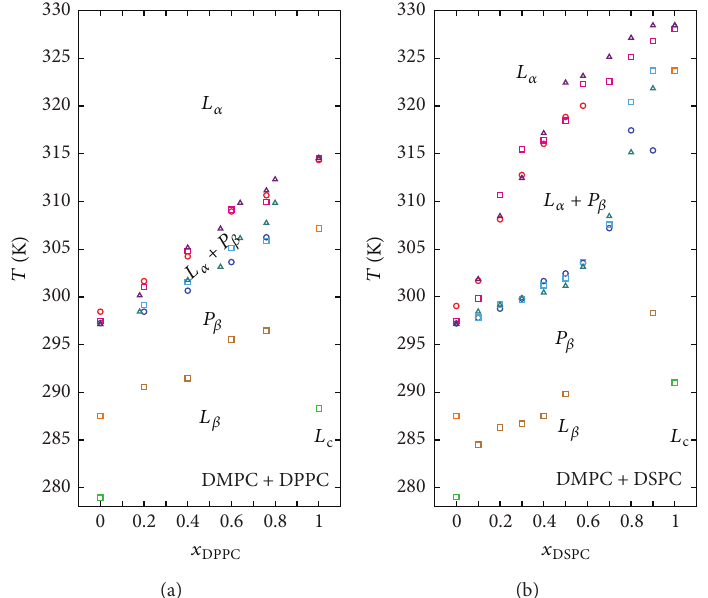
Figure 12: Phase diagram of (a) DMPC + DPPC mixtures and (b) DMPC + DSPC mixtures. Circles denote the values obtained with QCM- D, squares are pASC data, and triangles are literature values [27]. Reddish colours indicate the upper limit of the phase coexistence, blueish colours the lower limit. Green and brownish symbols denote the low-temperature transitions: the brownish symbols indicate the transition from the ripple phase to a lower-temperature phase and the green symbols the gel to sub-gel transition in the pure